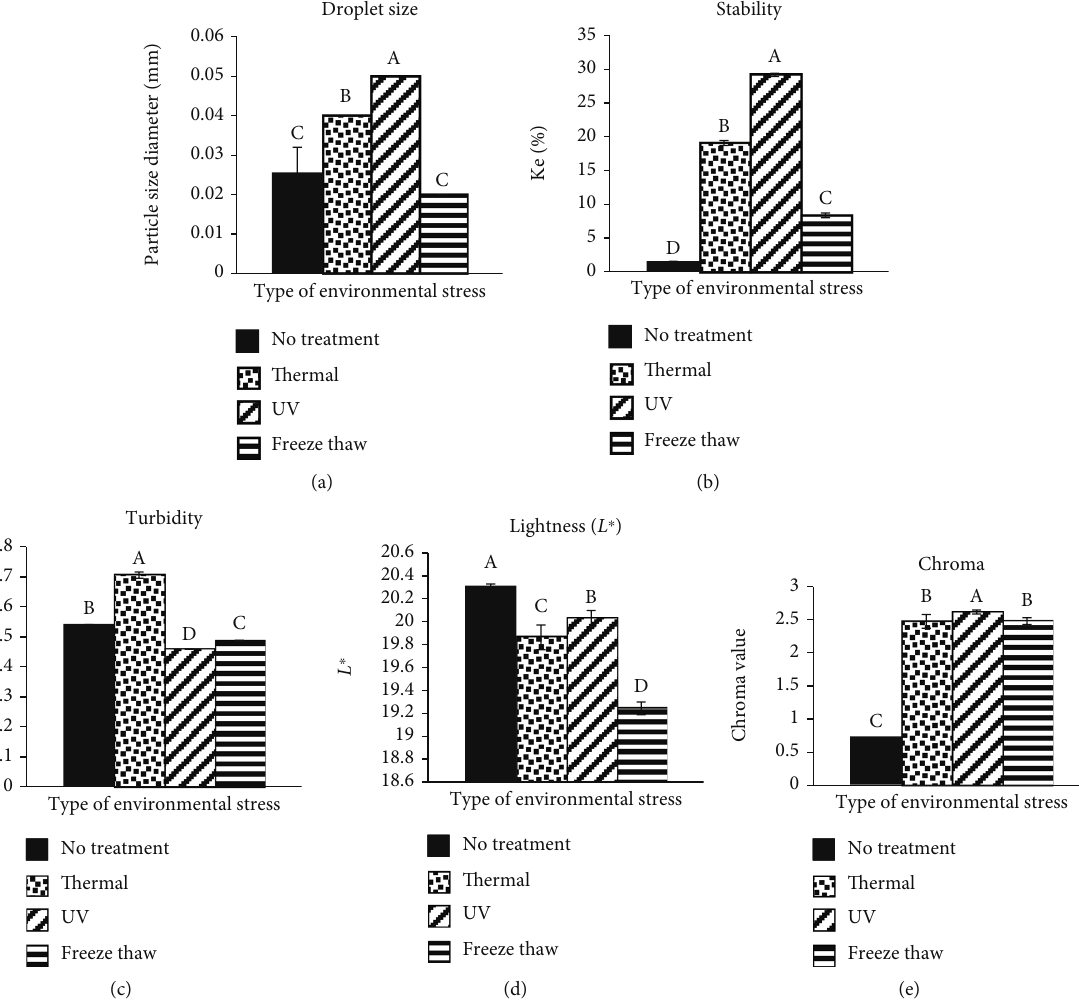
Figure 3: The e ff ect of environmental stress (thermal processing, UV radiation, and freeze-thaw) on droplet size (a), emulsion stability (b), turbidity (c), lightness (d), and chroma (e) on the best selected emulsi fi ed sample (emulsion contained 7% ( w / w ) sodium caseinate). Values are means ± standard deviations ( n = 3 ). Di ff erent letters show statistically signi fi cant di ff erences between values ( p < 0 : 05